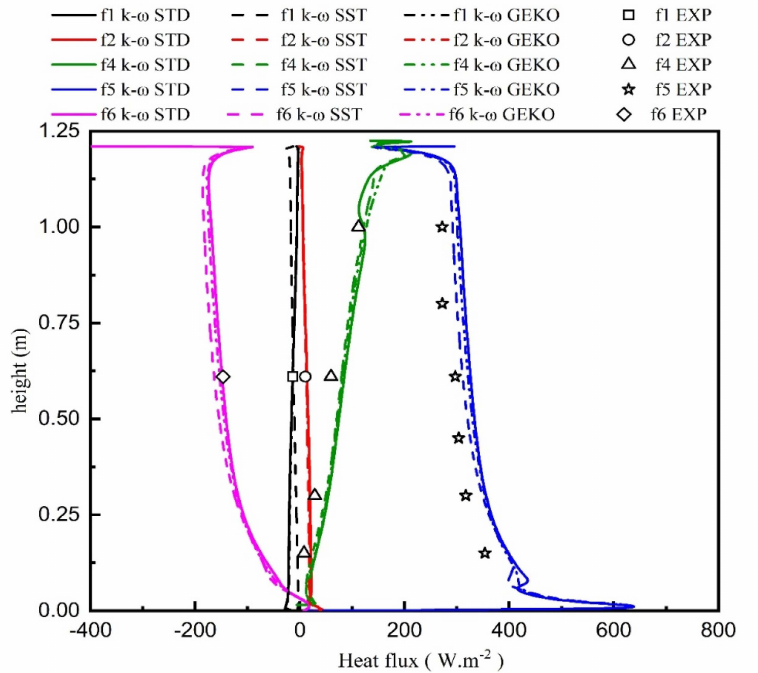
Figure 14. Experimental and numerical heat fluxes for the three glazings, according to k-w